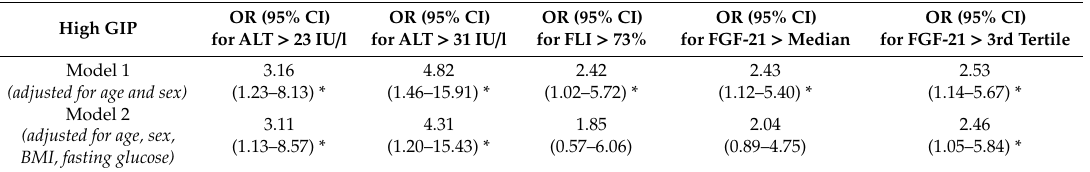
Table 3. Contributions of high plasma GIP level (odds ratios and 95% confidence interval (CI)) to the risk of elevated liver markers—logistic regression